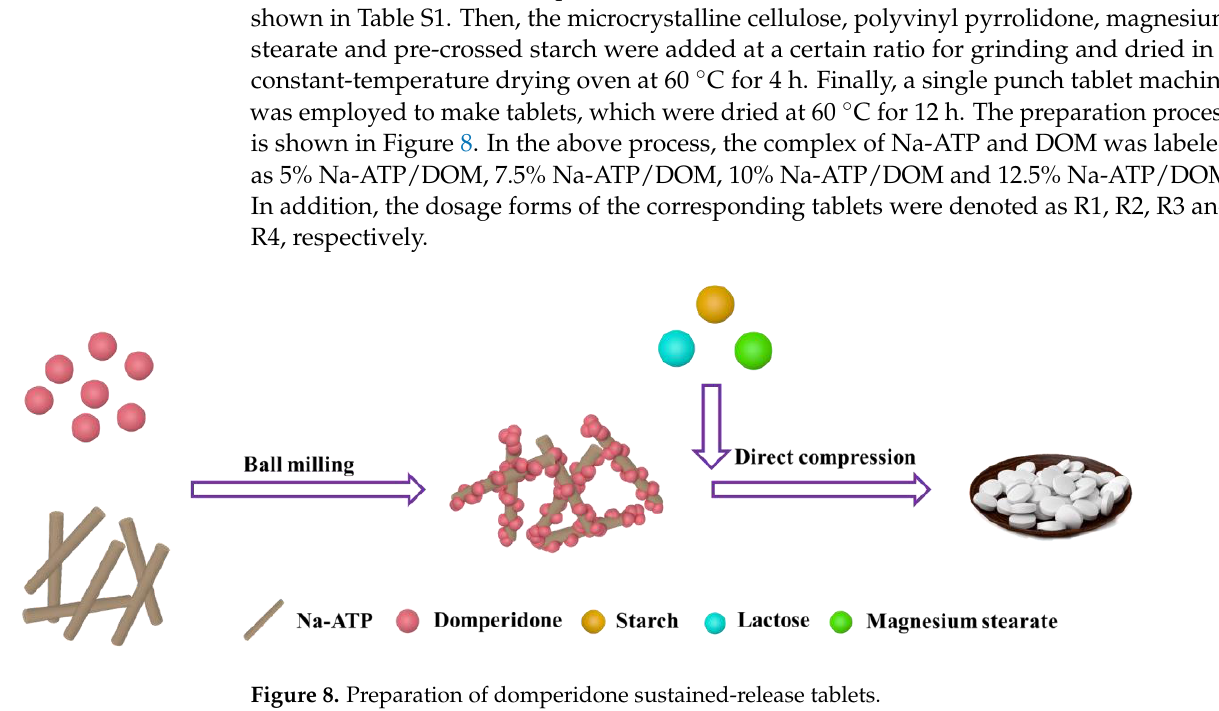
Figure 8. Preparation of domperidone sustained-release tablets.